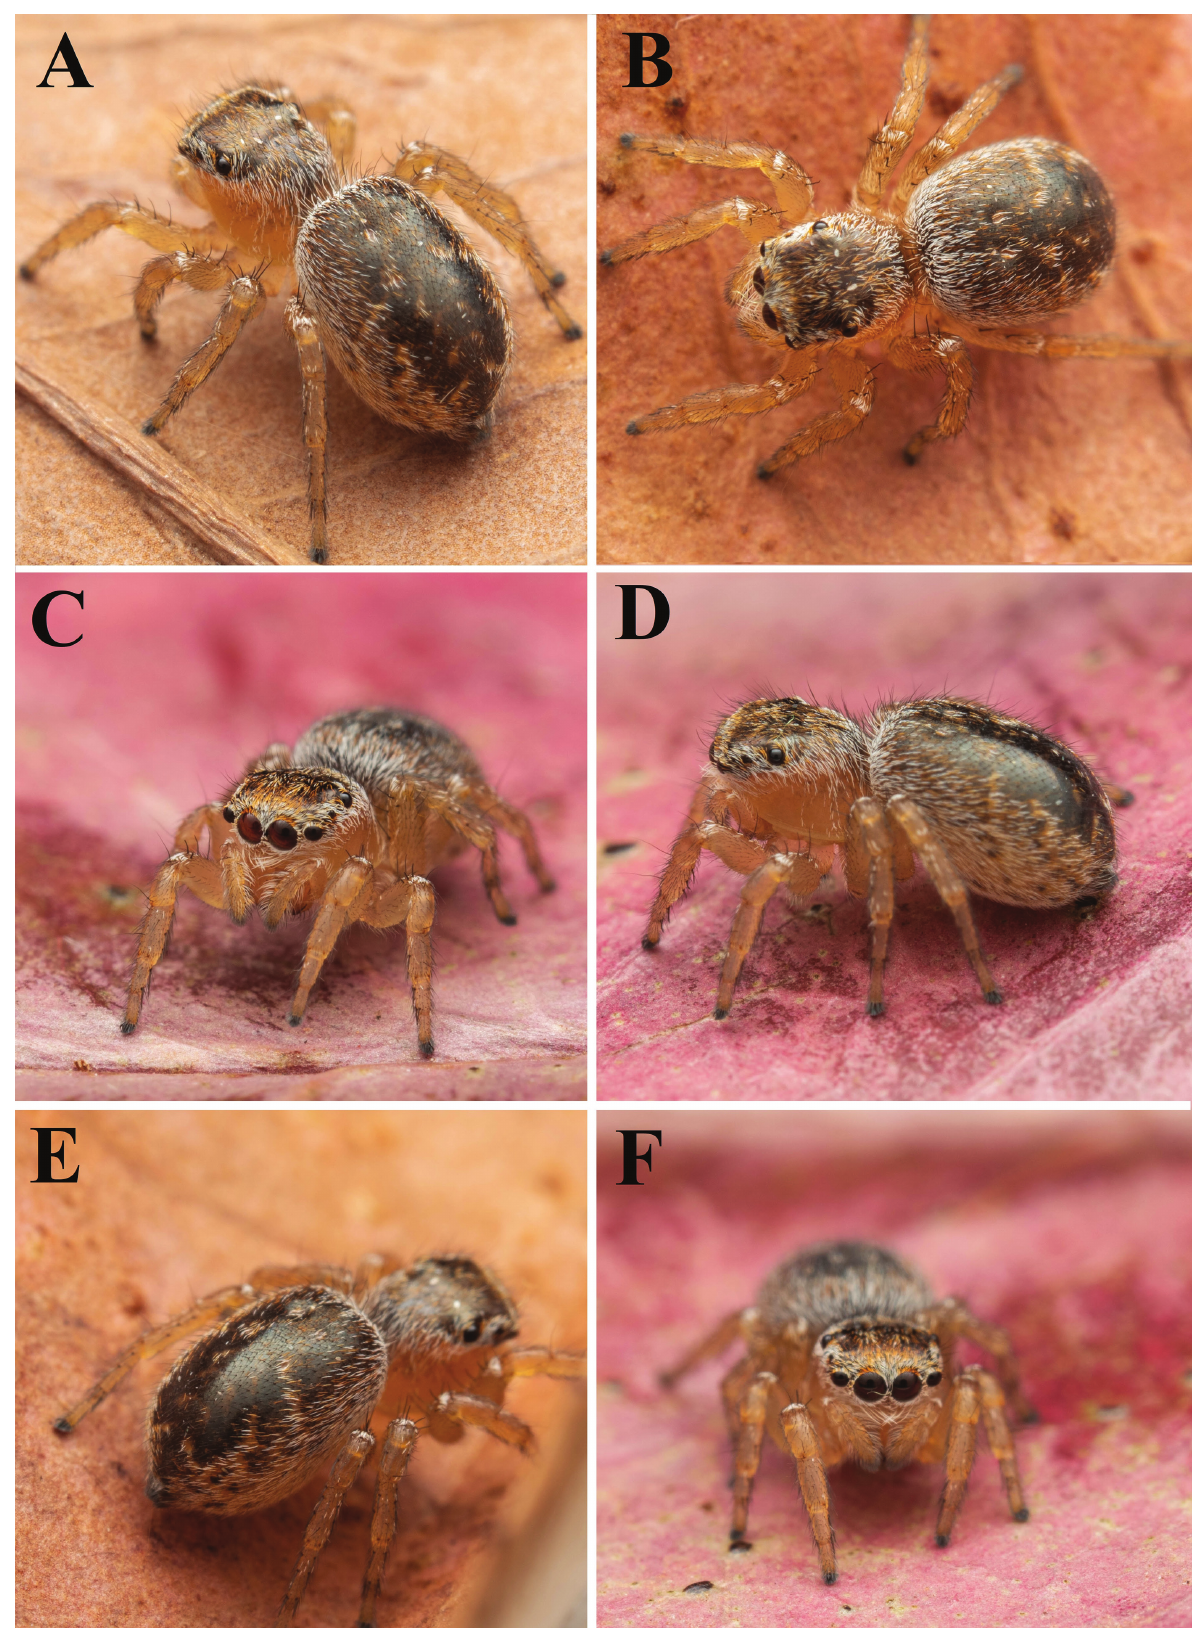
Figure 4. Habitus of living paratype female Maratus nemo sp. nov. (SAM NN30710) A dorsolateral view B dorsal view C antero- lateral view D lateral view E posterolateral view F anterior